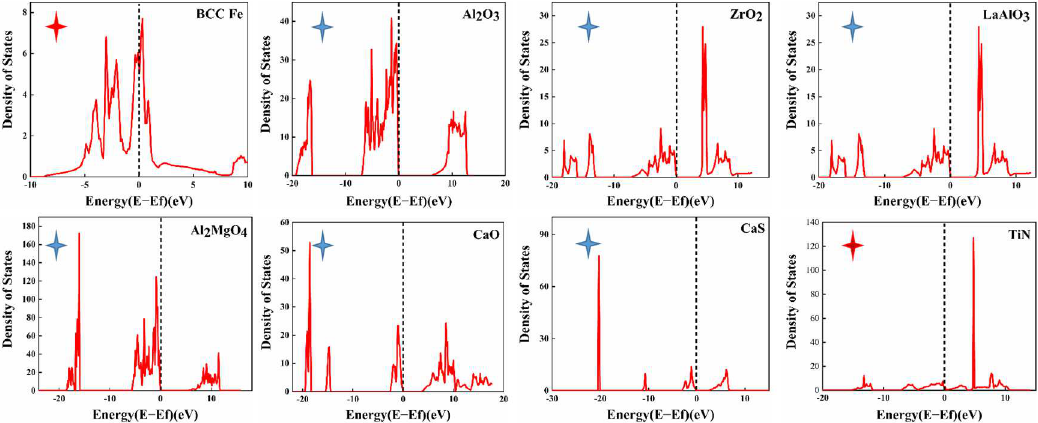
Figure 10. Density of states (DOS) analysis of the inclusions (the black dotted line represents the Fermi energy level).